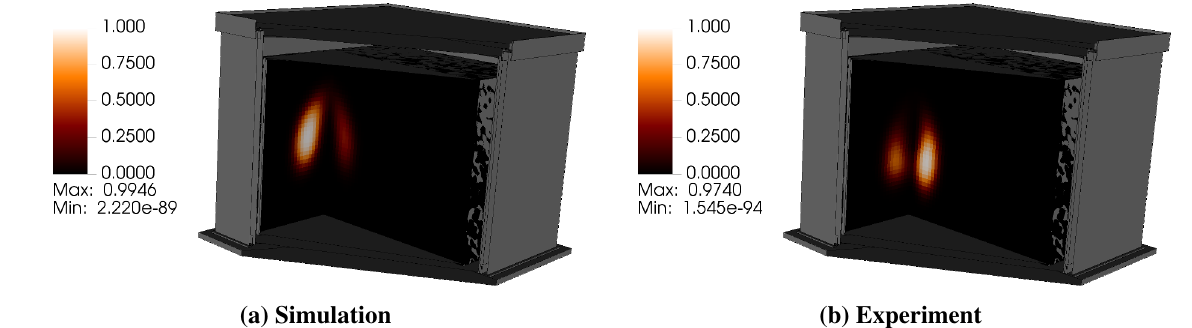
Figure 7: Image generated by VBO for simulation and experimental cases.